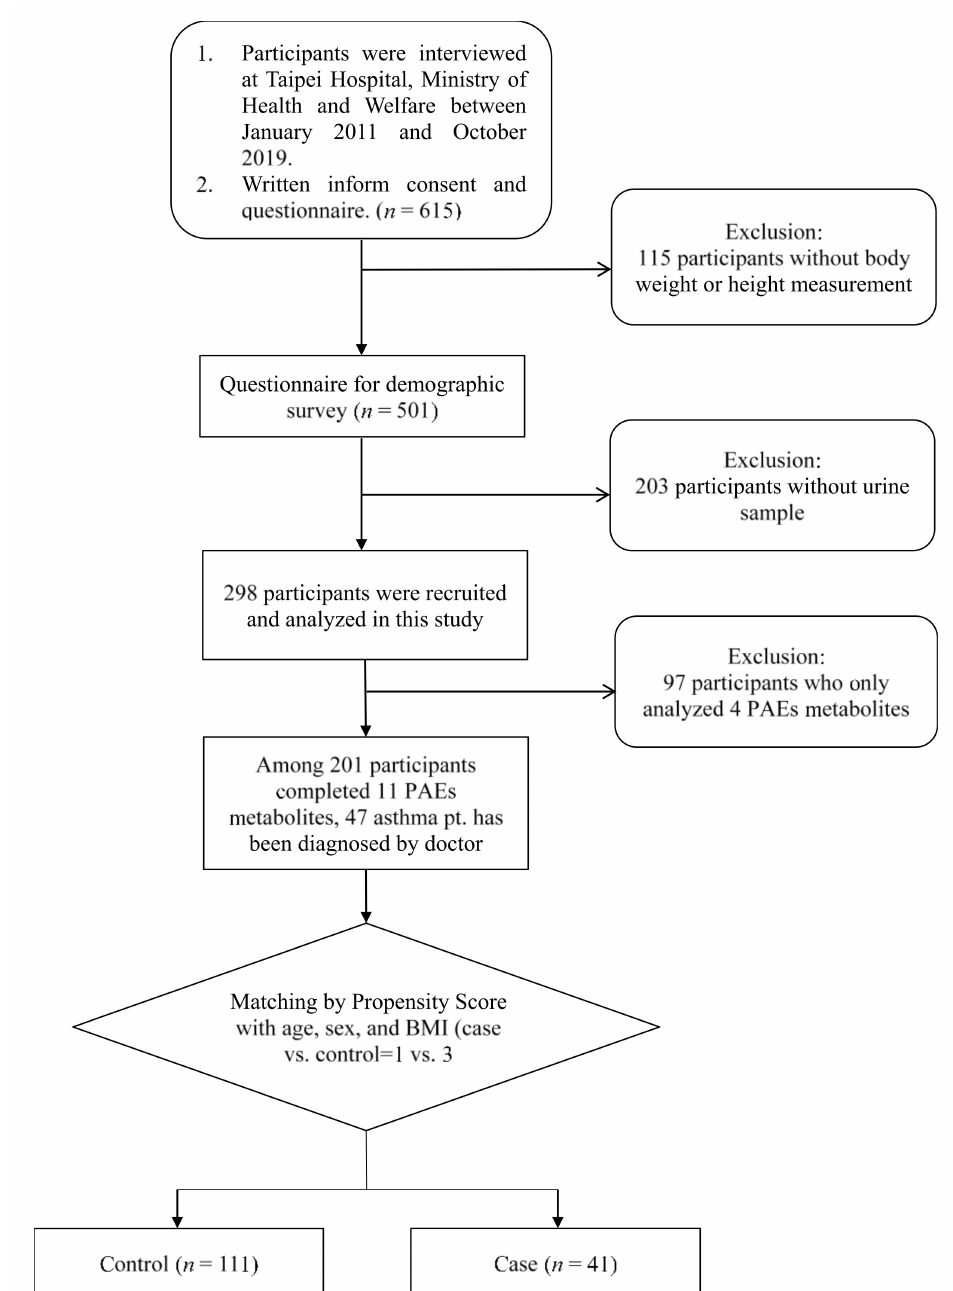
Figure 1. Flowchart of the recruitment of the